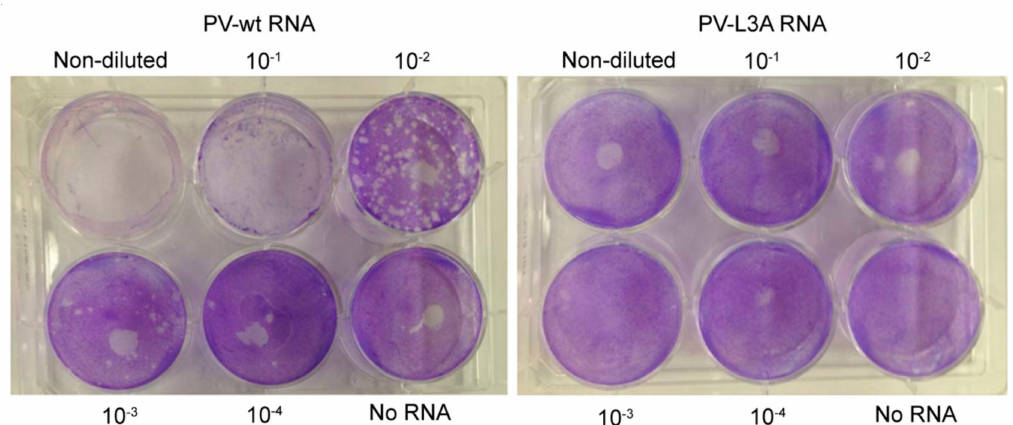
Figure 8. Mutations reducing helicity of the amphipathic α -helix of 2C protein block poliovirus infection. HeLa cells were transfected with serial dilutions of PV-wt or PV-L3A full-length poliovirus RNA transcripts. Cells were overlaid with DMEM growth medium containing FBS solidified with agarose at six hours post-transfection. To visualize plaques, the monolayer was stained with crystal violet at two days post RNA